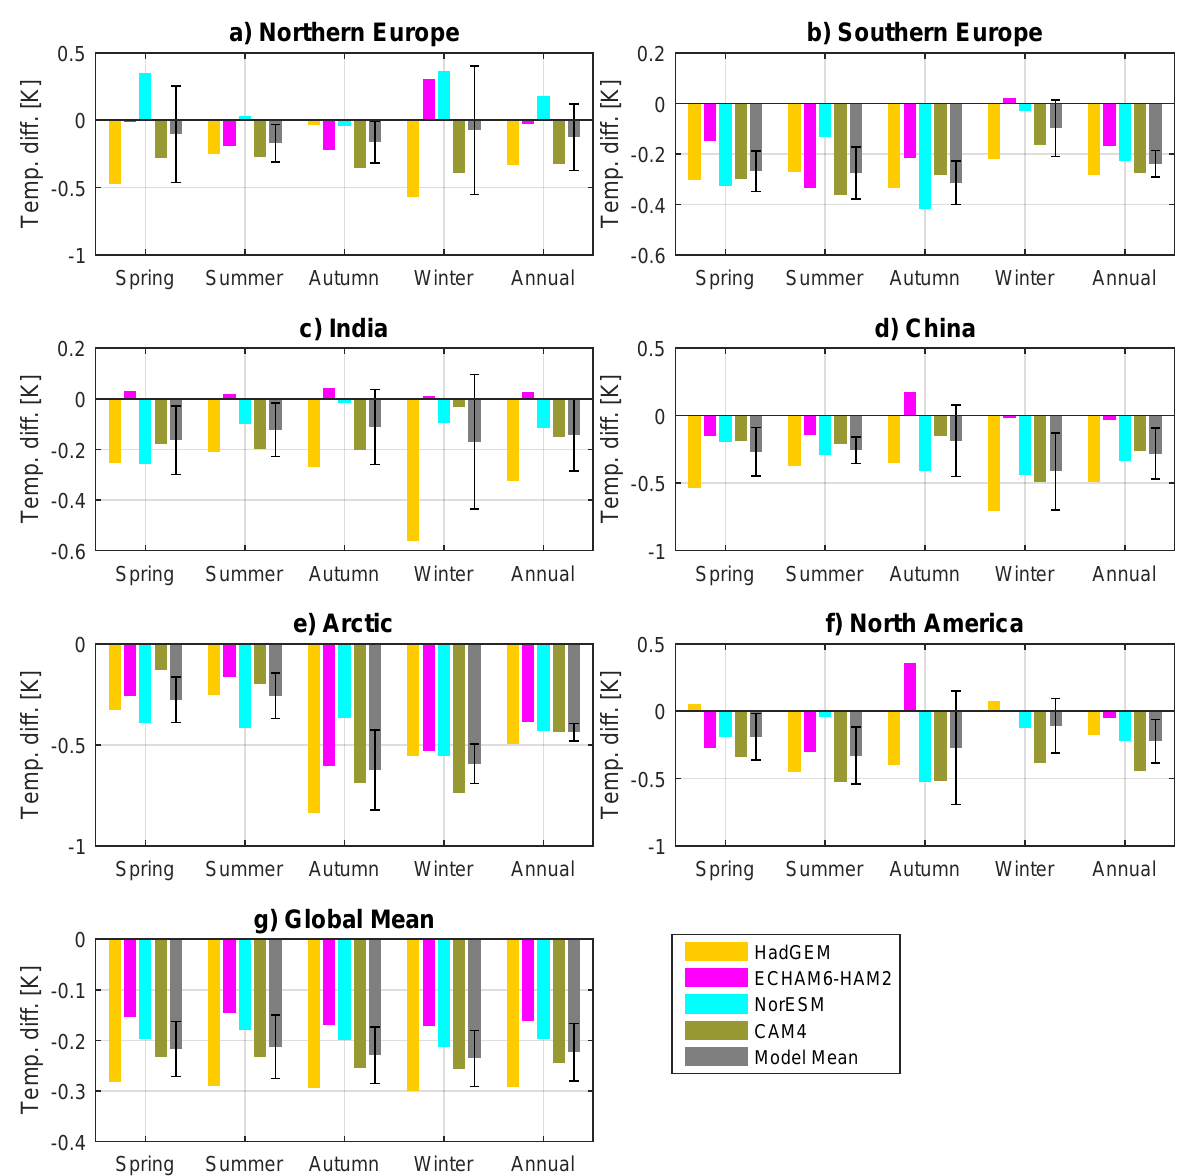
Figure 15. Seasonal and annual mean differences in surface temperatures (in K) in various regions (a–f) and for the whole globe (g) between transient simulations of the mitigation (MIT) and the current legislation (CLE) scenario, i.e. (MIT–CLE), averaged over the last 10 years of the simulations (2041–2050). Regions are defined as (a) 45–65 ◦ N, 10 ◦ W–65 ◦ E, (b) 30–45 ◦ N, 10 ◦ W–65 ◦ E, (c) 7–35 ◦ N, 68 ◦ E–90 ◦ E, (d) 24– 48 ◦ N, 80–132 ◦ E, (e) 60–90 ◦ N, 180 ◦ W–180 ◦ E, (f) 30–60 ◦ N, 120–50 ◦ W. Results are shown for the four ECLIPSE models individually and for the multi-model mean. Negative values mean that temperatures are lower in the MIT than in the CLE scenario. Error bars on the model-mean values show the standard deviations of the individual model